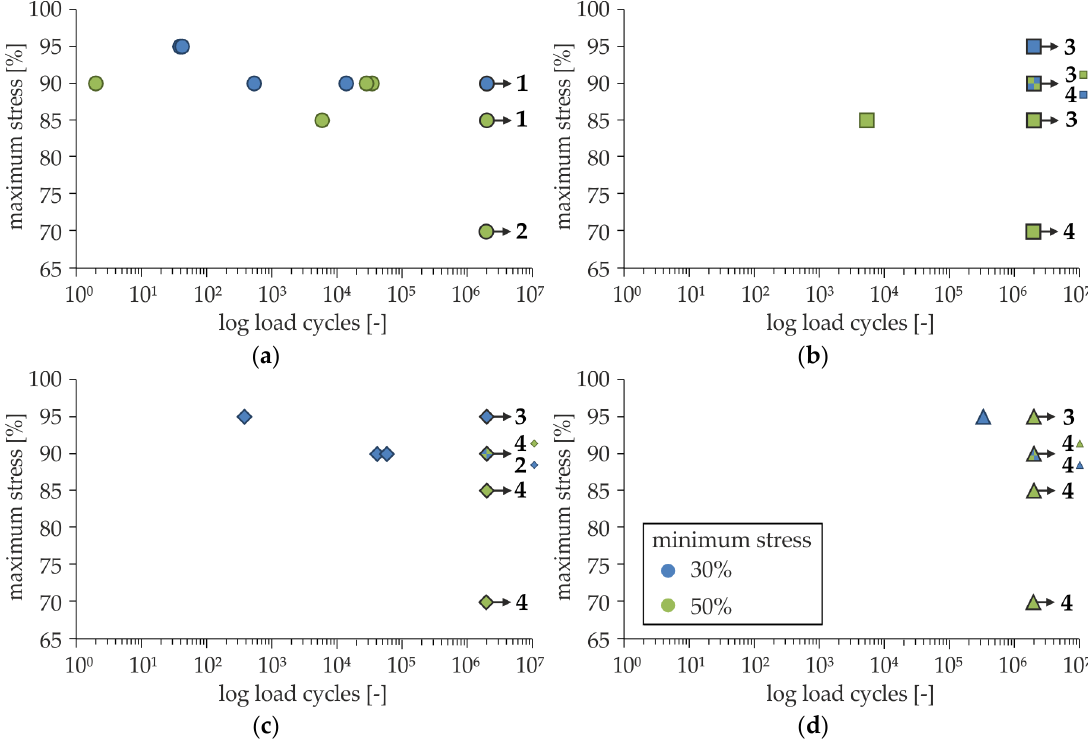
Figure A8. S-N diagrams with relative maximum stresses and two different minimum stresses: ( a ) anchorage length = 1 a ; ( b ) anchorage length = 2 a ; ( c ) anchorage length = 3 a ; and ( d ) anchorage length = 4 a .